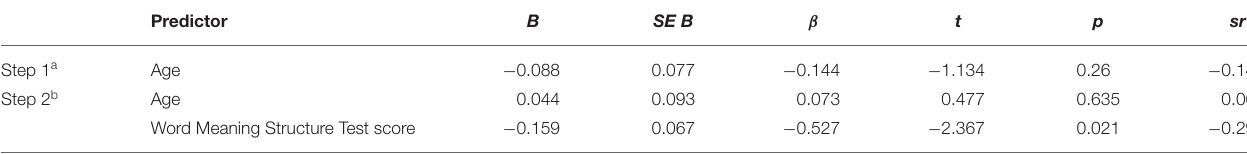
TABLE 3 | Predicting the number of inaccurate answers in children’s answers in response to specific option-posing questions ( N = 63). Predictor